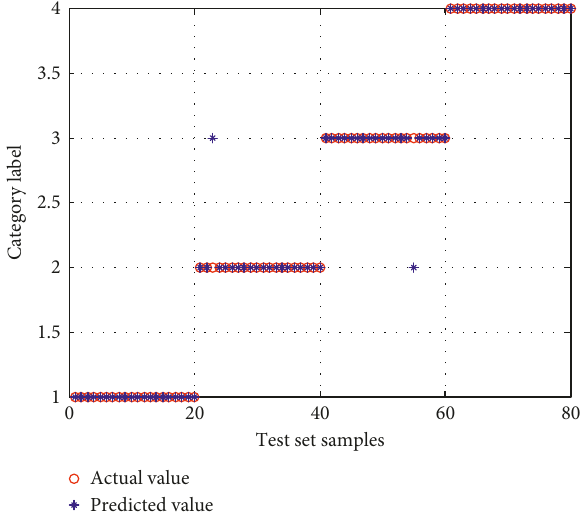
Figure 19: SFLA-SVM predicted results from improving the threshold